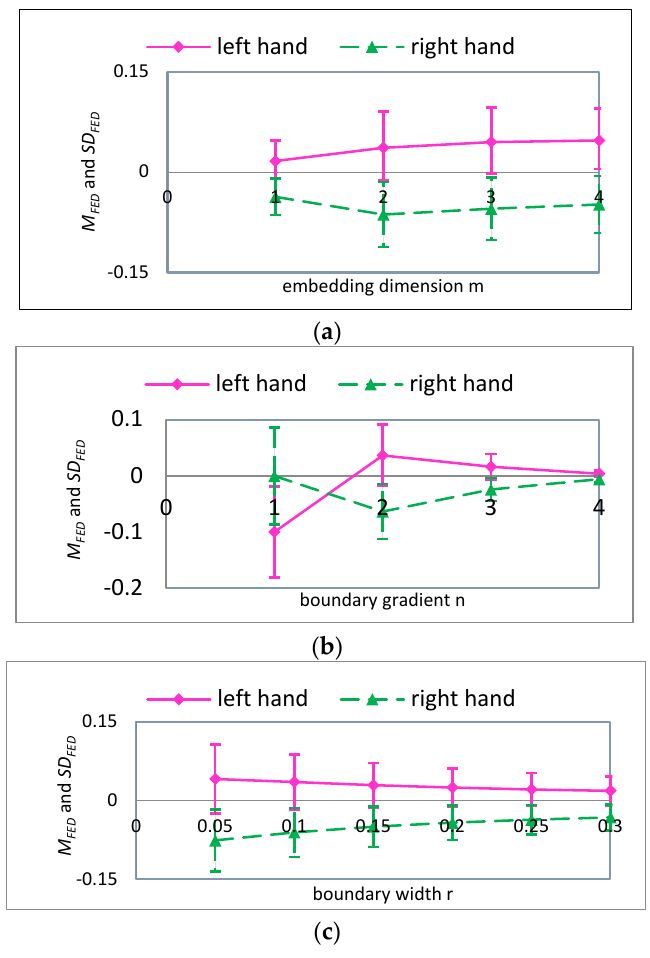
Figure 6. For =1 τ , the mean and standard deviation of FED curves for input variables ( a ) Figure 6. For τ = 1, the mean and standard deviation of FED curves for input variables ( a ) embedding embedding dimension m ; ( b ) boundary gradient n ; and ( c ) boundary width r . dimension m ; ( b ) boundary gradient n ; and ( c ) boundary width r